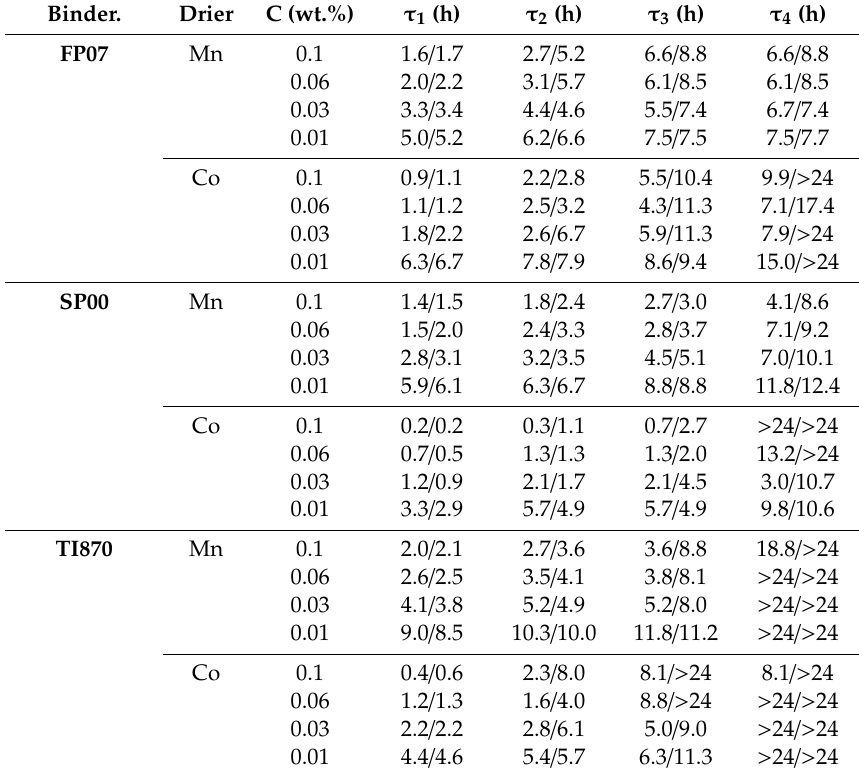
Table 4. Drying times of test coatings for formulations of high-solid alkyd binders. 1.